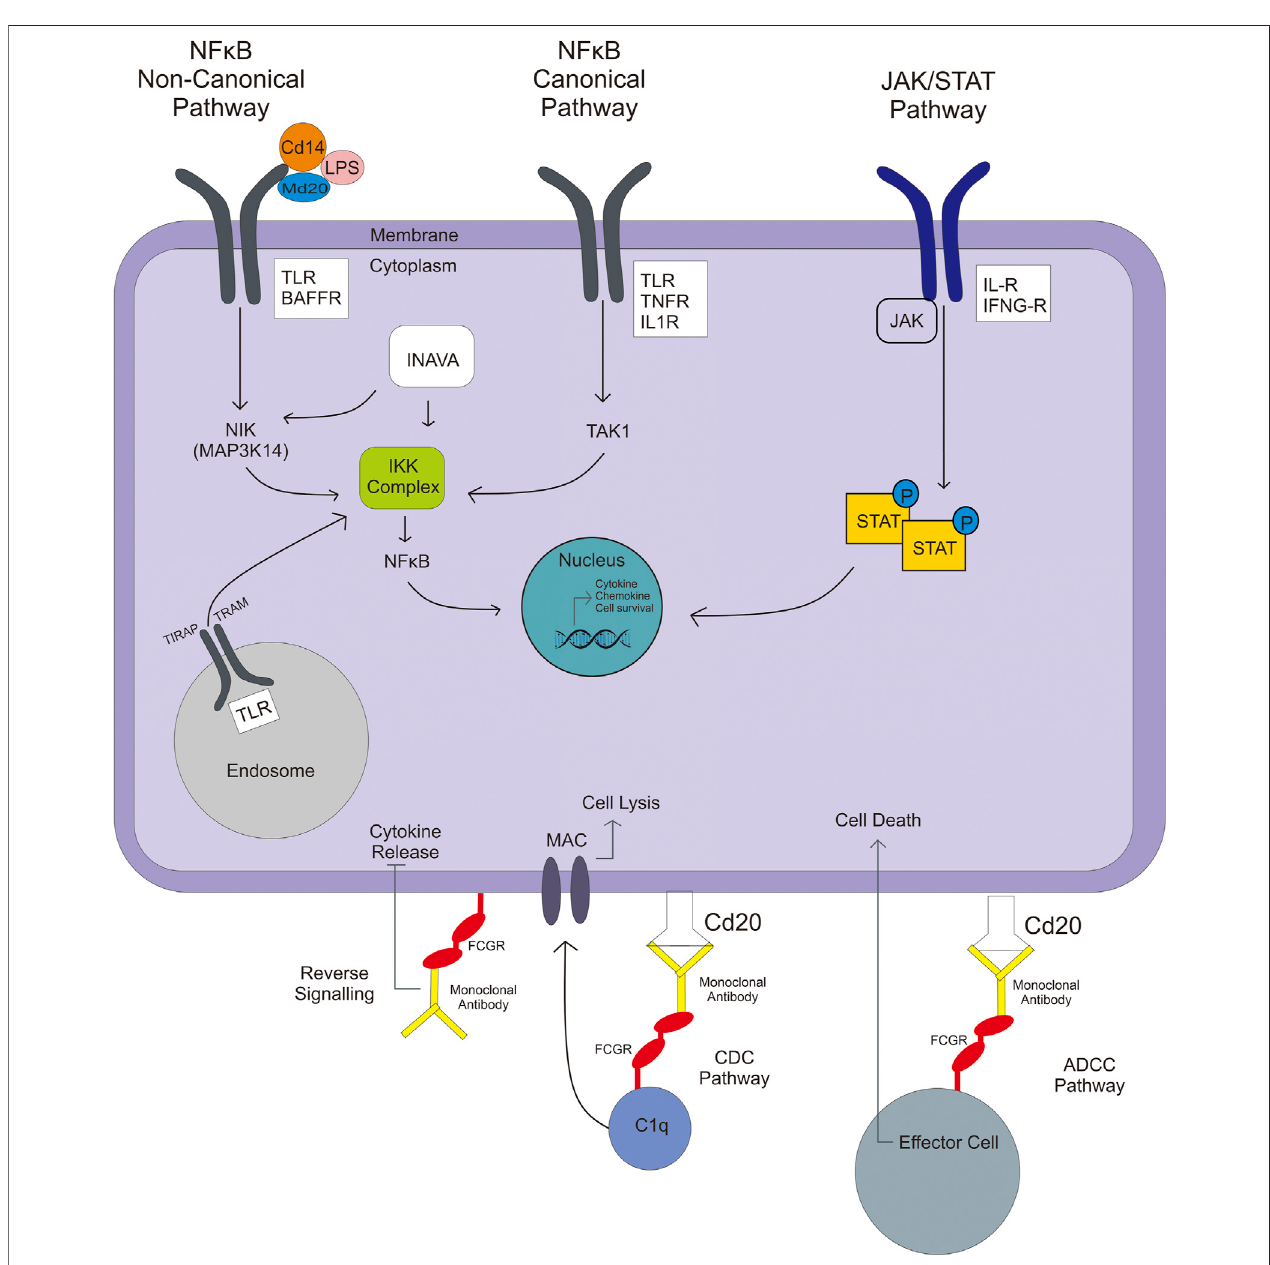
FIGURE 3 | NFkB pathways involved in the activation of TLR or IL gene expression include noncanonical, canonical, and JAK/STAT pathways, which result in immunity responses like chemokine/cytokine production or survival cell.